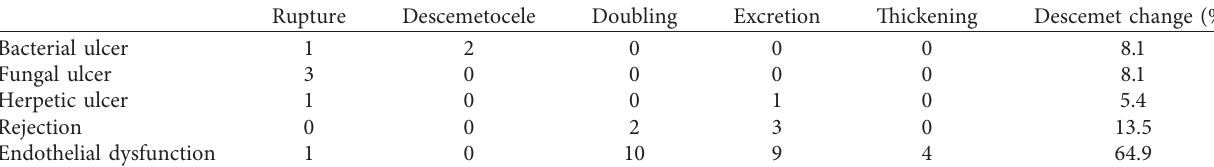
Table 2: Prevalence of Descemet membrane changes in the different causes of corneal